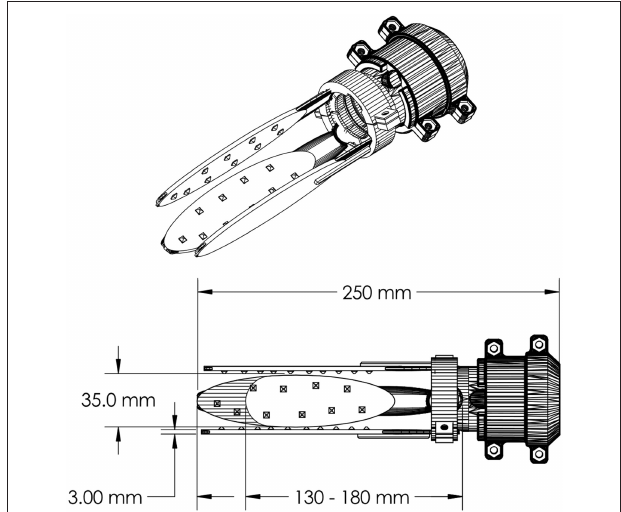
FIGURE 1 | Functional-test socket design with important dimensions of the socket indicated. Only three of the four flexible struts are depicted. The socket can accommodate variable residual limb lengths by trimming the struts to the desired length. The struts can also be heated and reshaped to adapt to the residual limb shape of a given user. The struts are nested inside of a collet which in turn houses a custom adapter for a terminal device. The adapter for the TASKA hand is pictured here. The socket design has been open-sourced and is available for other researchers at https://github.com/utahneurorobotics/ u-of-u-functional-test-socket.